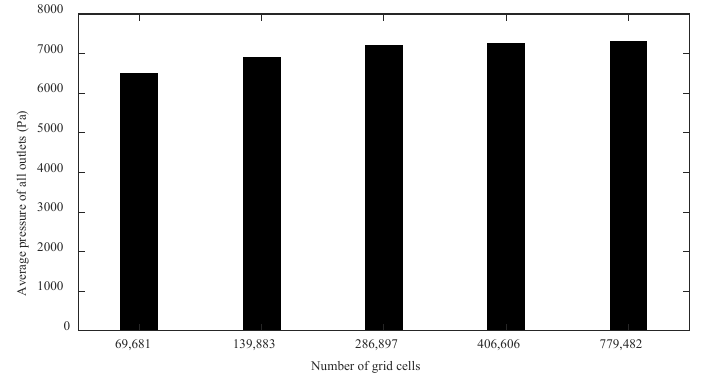
Figure 10. Dependency analysis for CHN03 [19].